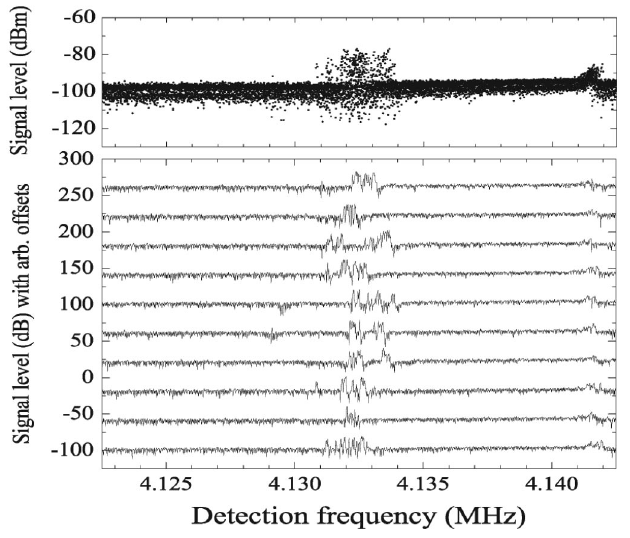
FIG. 5. Responses of the vertical quadrupolar oscillations mea- sured under a bunch current of 10 mA. Lower: ten measured traces which are shown separately by adding offsets (40 dB between neighboring traces). Upper: superposition of the ten traces with the lines between data points omitted.